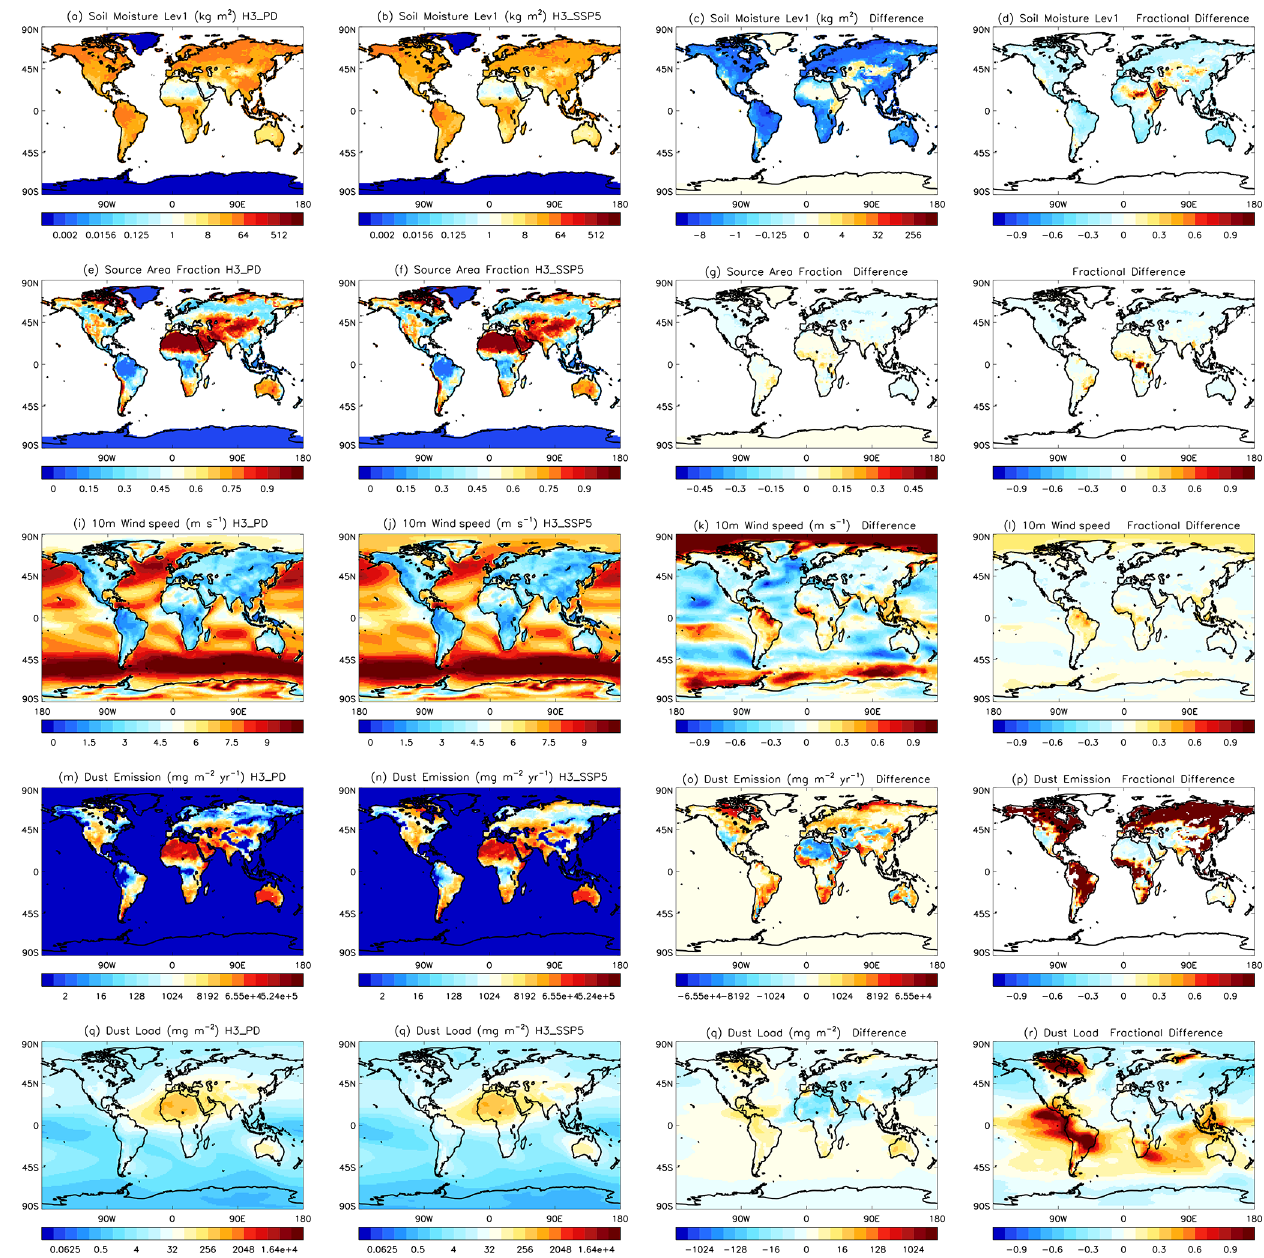
Figure 12. As in Fig. 11 but for H3_PD and H3_SSP5.